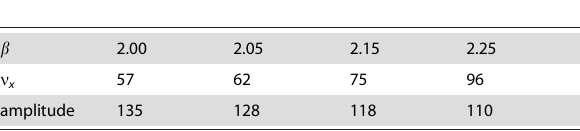
Table 3. The effect of anomalous fractional order b to longitudinal wave velocity v x and